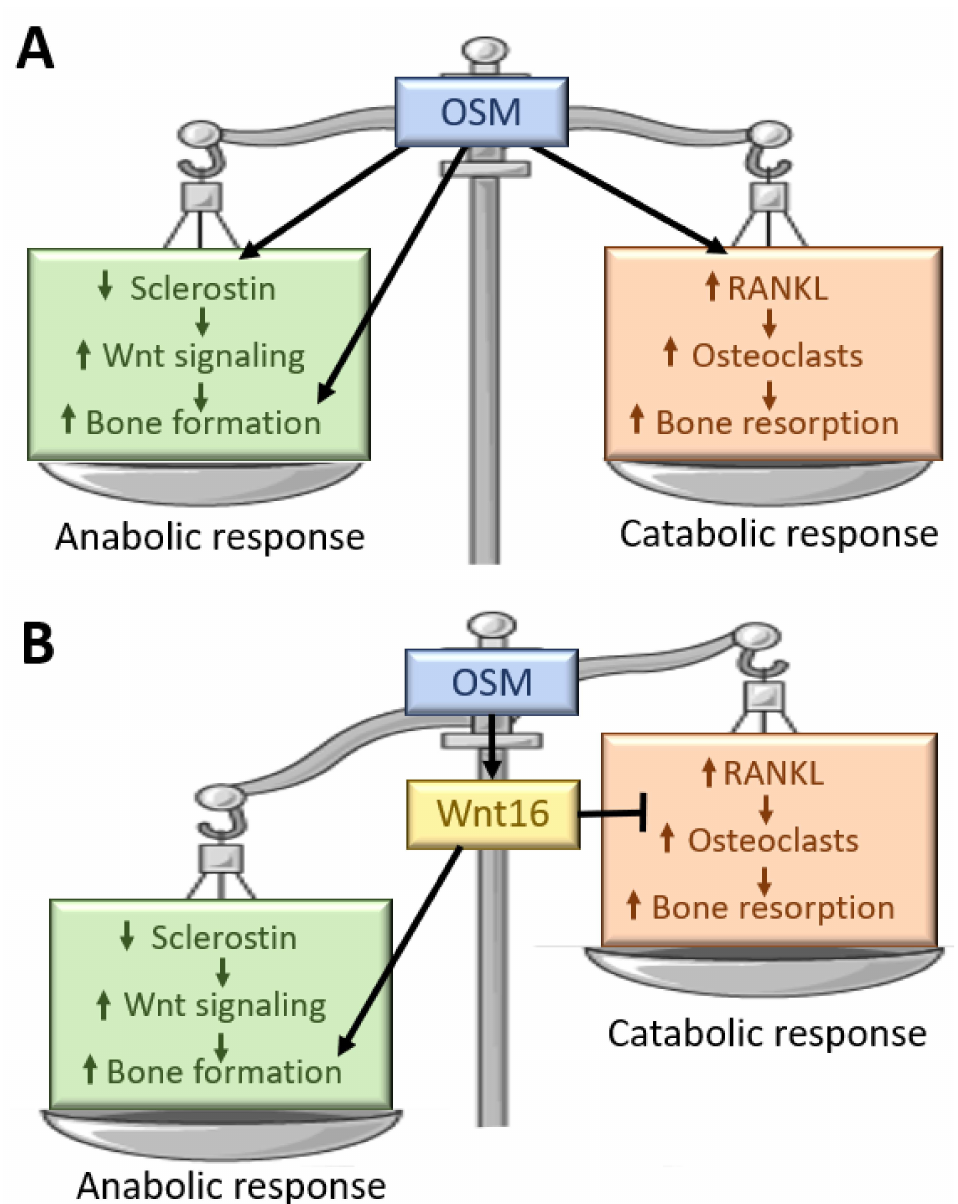
Figure 5. ( A ) OSM is believed to stimulate bone formation by decreasing sclerostin